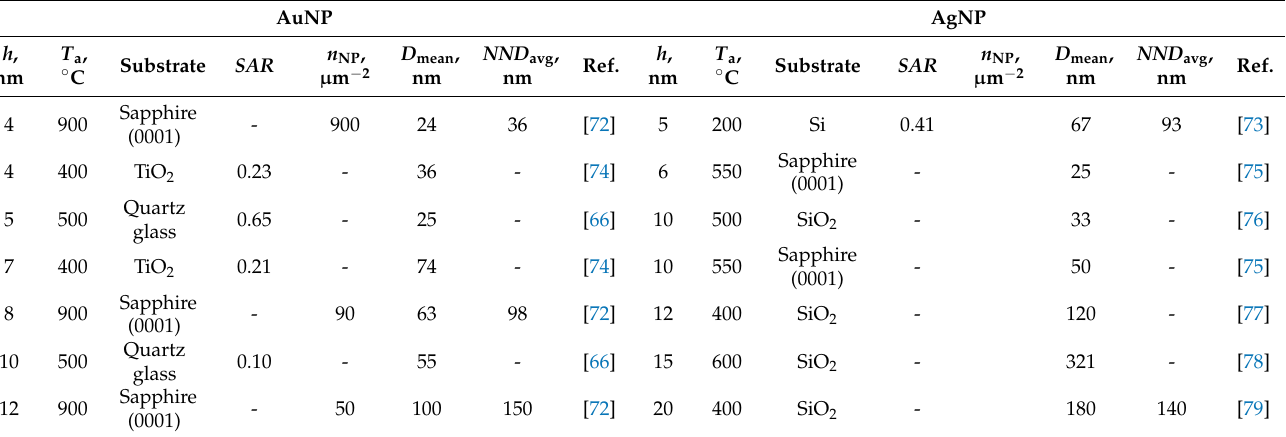
Table 3. Characteristics found in the literature of AuNP and AgNP after annealing metal thin films: surface area ratio ( SAR ), density of NP ( n NP ), mean diameter of NP ( D mean ), and distances between-NP (border-to-border) to all their neighbors ( NND avg